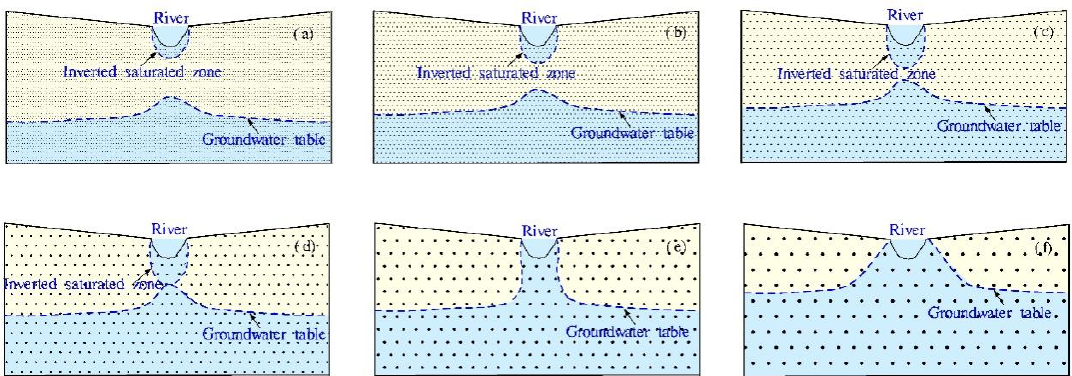
Figure 14. Schematic diagram of river and groundwater evolution under different particle sizes in aqueous media.